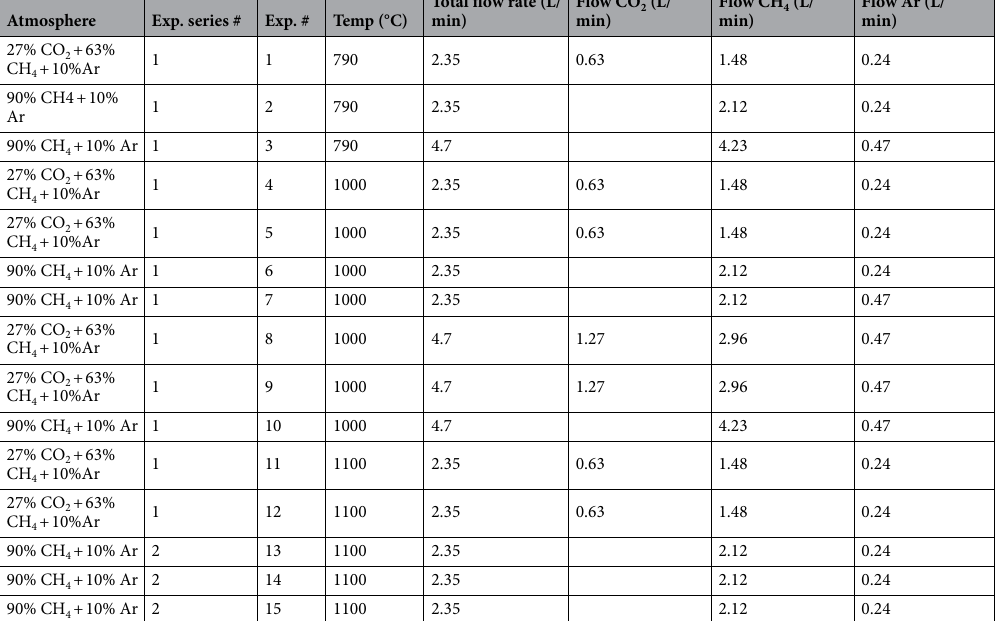
Table 1. Overview of all